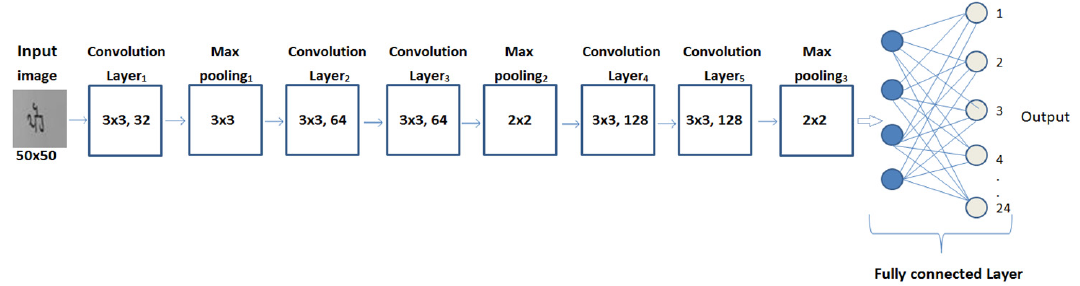
Figure 4. Architecture of proposed CNN model.